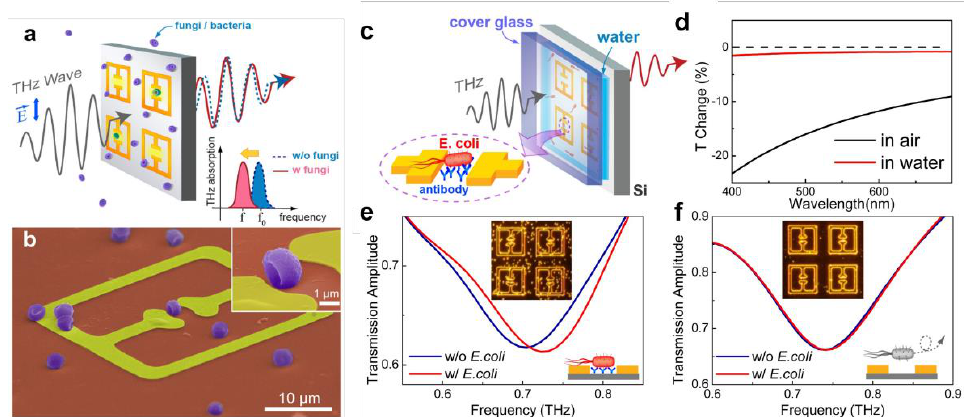
Figure 3. Sensing microorganisms using THz metamaterials. ( a ) A schematic representation of sensing of microorganisms with THz metamaterials. ( b ) A colour-enhanced SEM image of metamaterials coated by penicillia. The inset shows a magnified image of the fungi located in the micro-gap. ( c ) A schematic of bacteria ( E. coli .) detection in an aqueous solution. The Si substrate was coated with antibodies specific to E. coli . ( d ) Transmittance spectra of the E. coli -coated (density of 0.078 μm 2 ) quartz substrate in aqueous (red line) and ambient (black line) conditions. ( e ) THz transmission before (blue line) and after (red line) the deposition of E. coli on the functionalised metamaterials in aqueous environments. Inset shows the dark-field microscopic image after the deposition of E. coli . ( f ) THz transmission before (blue line) and after (red line) the deposition of E. coli on the sensor without the antibody functionalisation. Inset shows the dark-field microscopic image after the deposition of E. coli . [60] Copyright © 2014 Springer Nature, S. J. Park, et al.